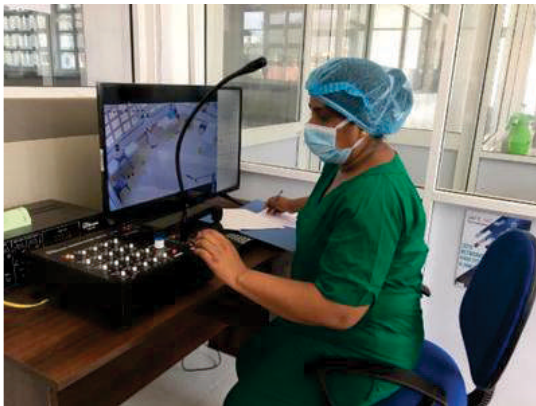
Figure 4: Isolation Centre at BH Marawila with new technology